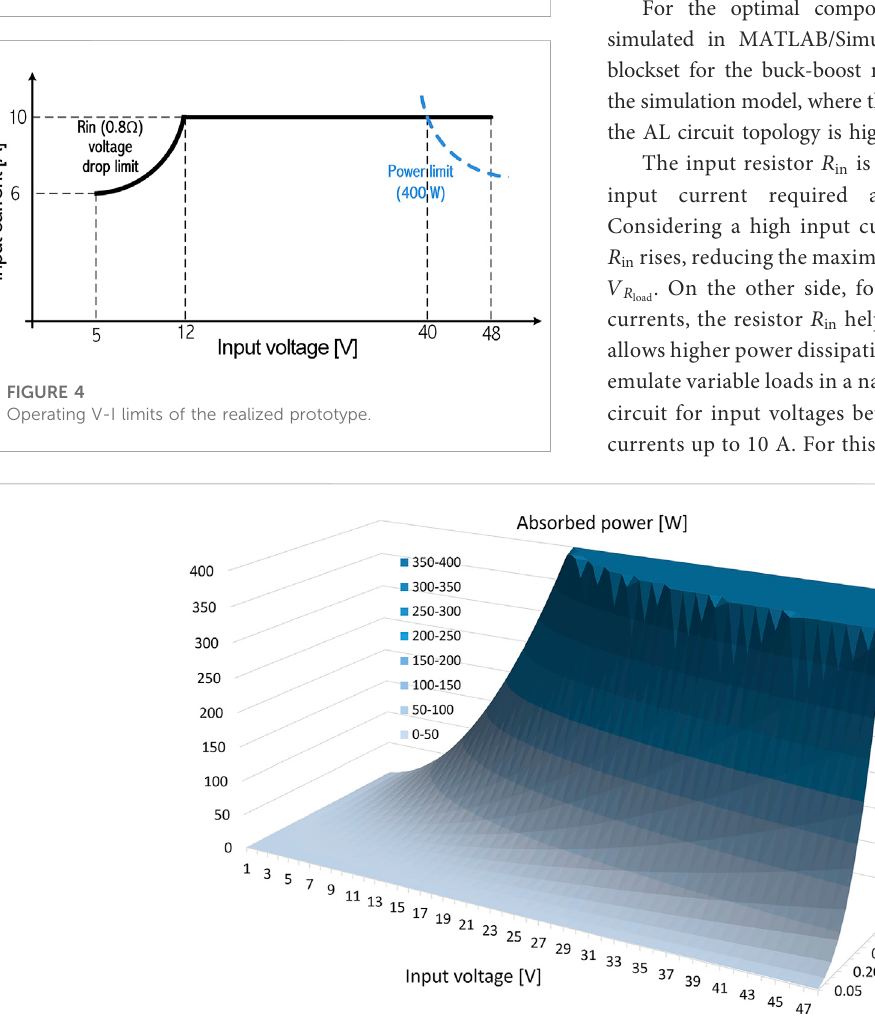
FIGURE 3 Total input absorbed power versus the duty-cycle at fi xed input voltage V in = 5